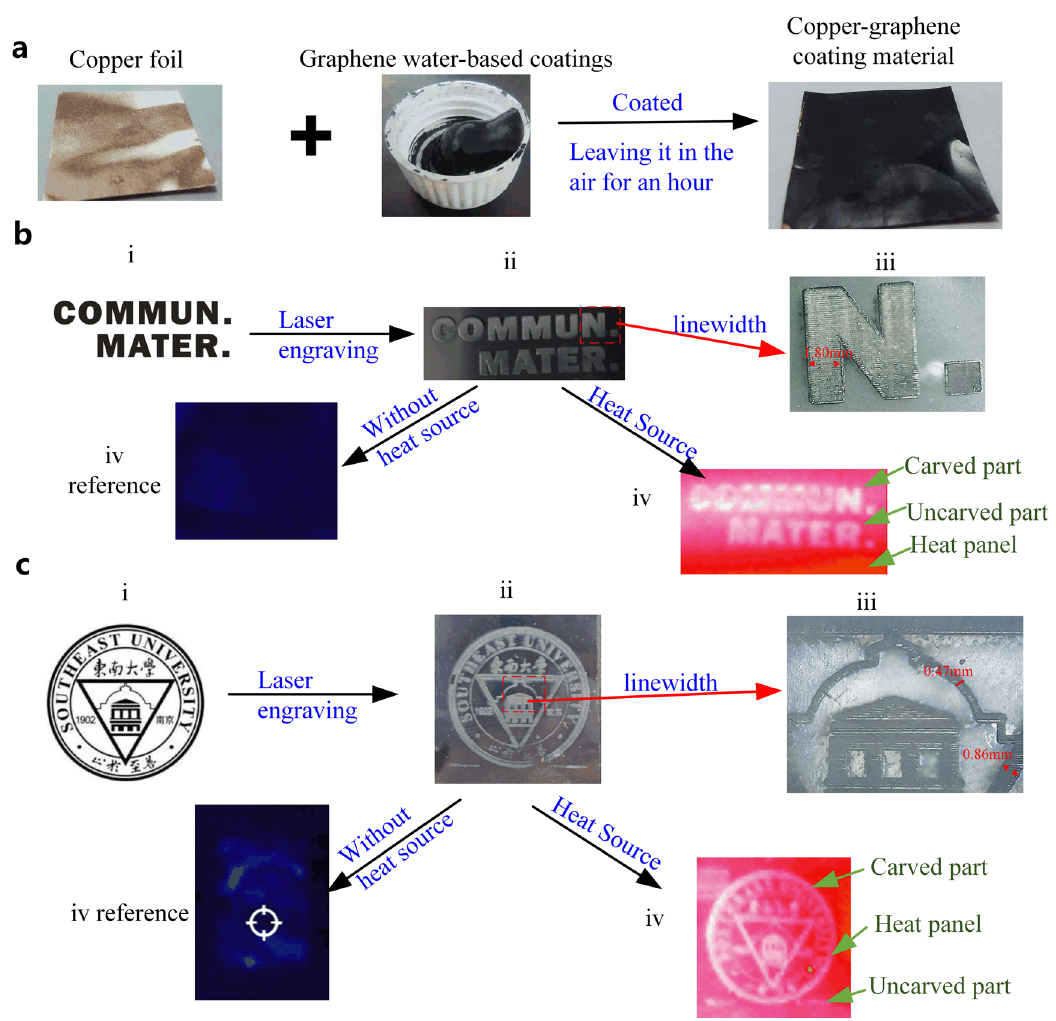
Fig. 1 The processes of the CGC materials, CM logo, and SEU logo surfaces. a The schematic of CGC materials. b (i)Selection a CM logo; (ii) Engraving the CGC material through CO 2 laser engraving machine to form the CM logo surface; (iii) Zooming in the red dashed box of CM logo surface to observe the detail of the processing and measure the linewidth through the electronic magnifying glass; The linewidth of char “ N ” is 1.80 mm; (iv and iv reference) Taking photos using an IR camera with and without heat source. c (i)Selection a complex logo; (ii) Engraving the CGC material through CO 2 laser engraving machine to form the SEU logo surface; (iii) Zooming in the red dashed box of the SEU logo surface to observe the smoothness of the curve and measure the linewidth; The linewidth of the curve and bold straight line are the 0.47 and 0.86 mm; (iv and iv reference) Taking photos of the SEU using an IR camera with and without attaching to the surface of